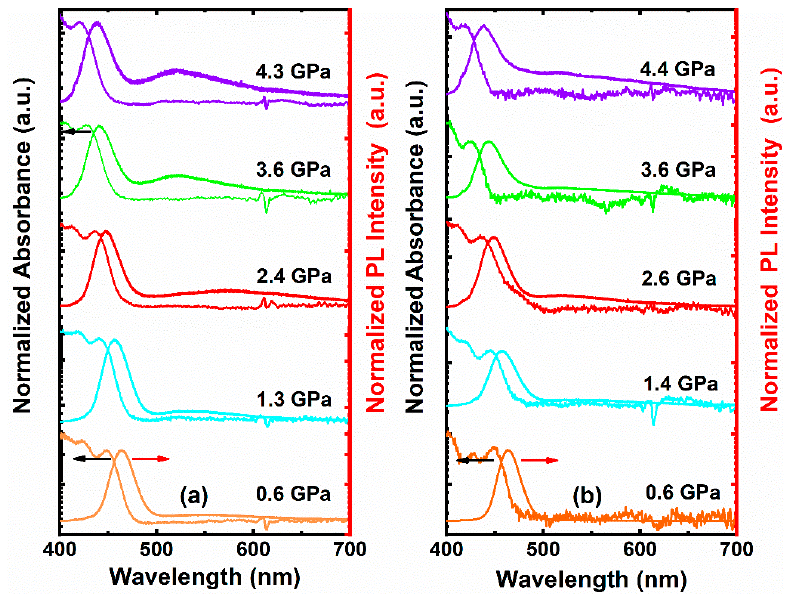
Figure 2. Pressure-dependent UV–Vis absorption and PL spectra of ( a ) CdSe/ZnS–QDs and ( b ) CdSe/ZnS–QDs–polymethyl methacrylate (PMMA).